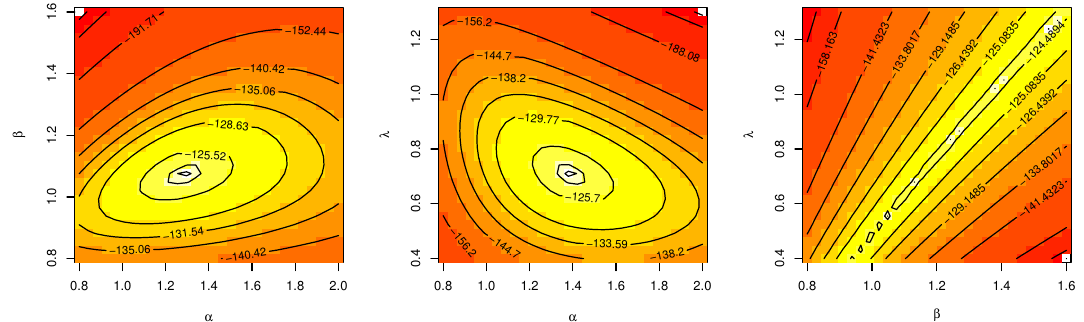
Figure 10. Contour plot of UEPD for the milk production